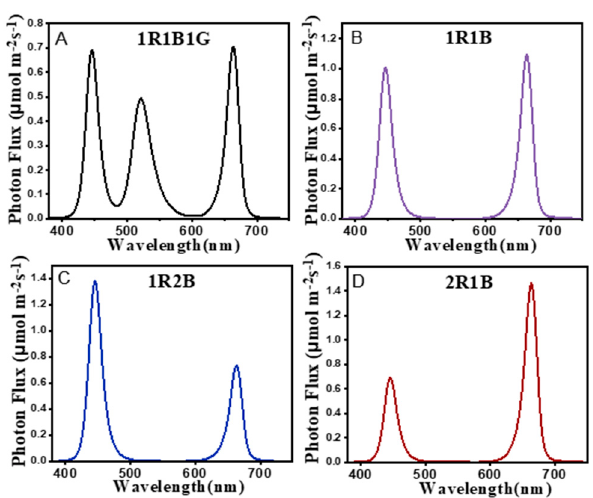
Figure 6. Photon flux density in the five treatments. The spectral distribution was measured by a spectrometer (ALP-01, Asensetek,